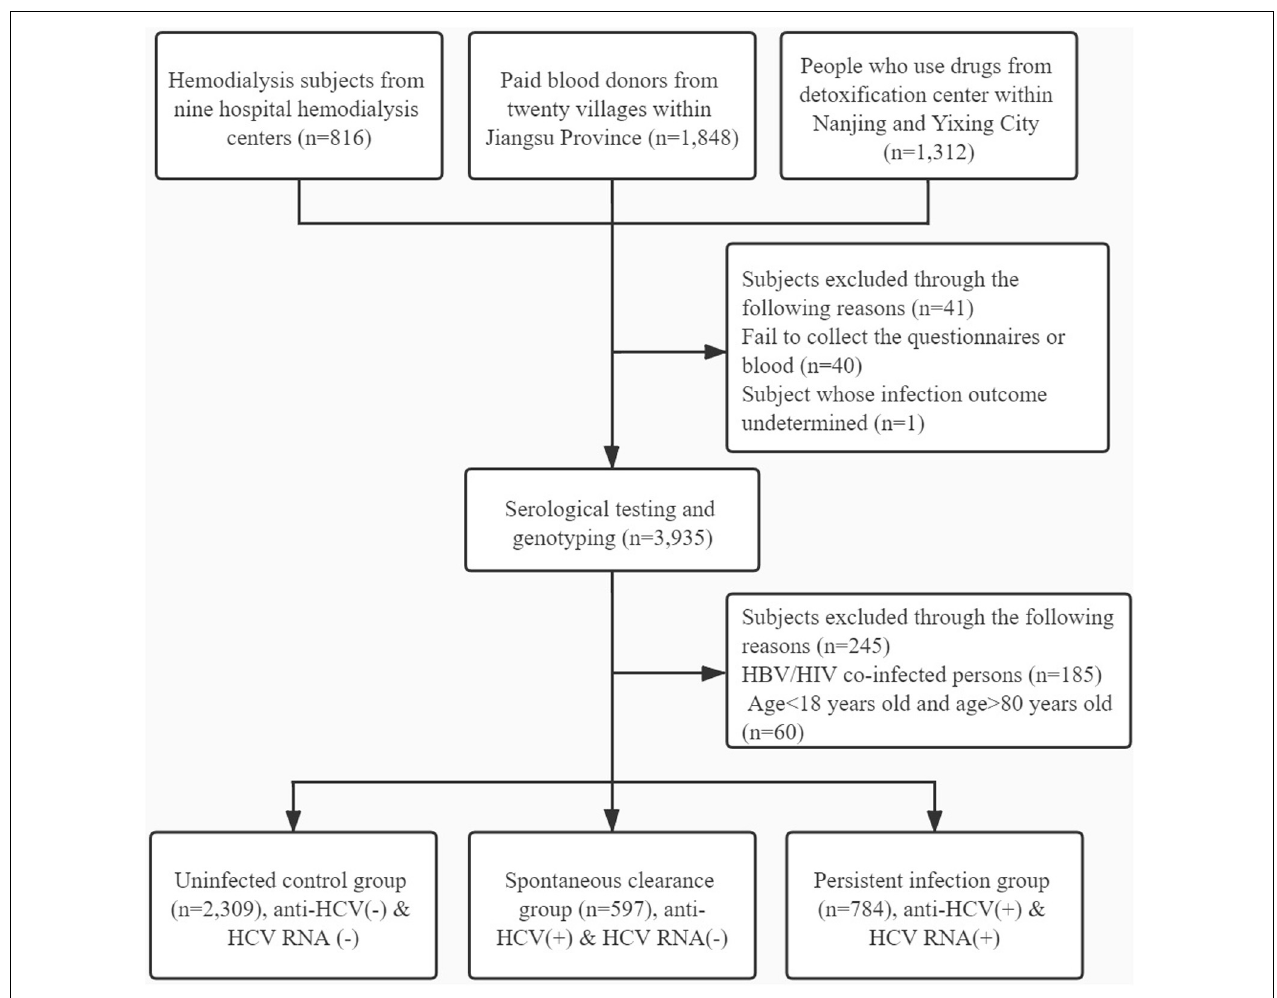
FIGURE 1 | Flow diagram for inclusion of participants.